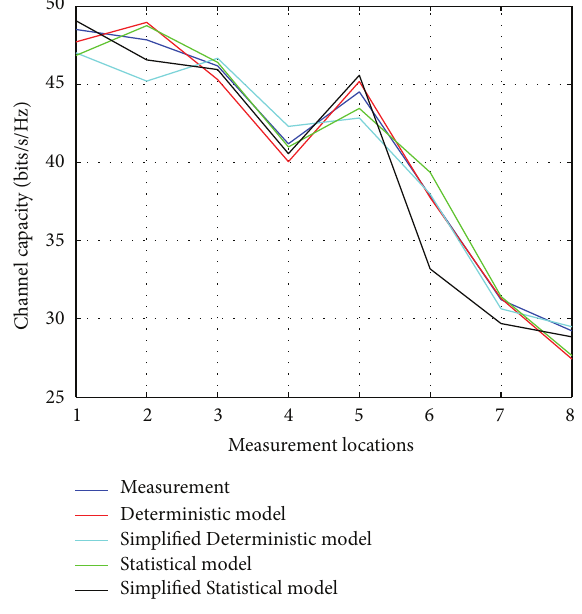
Figure 15: Channel capacity in